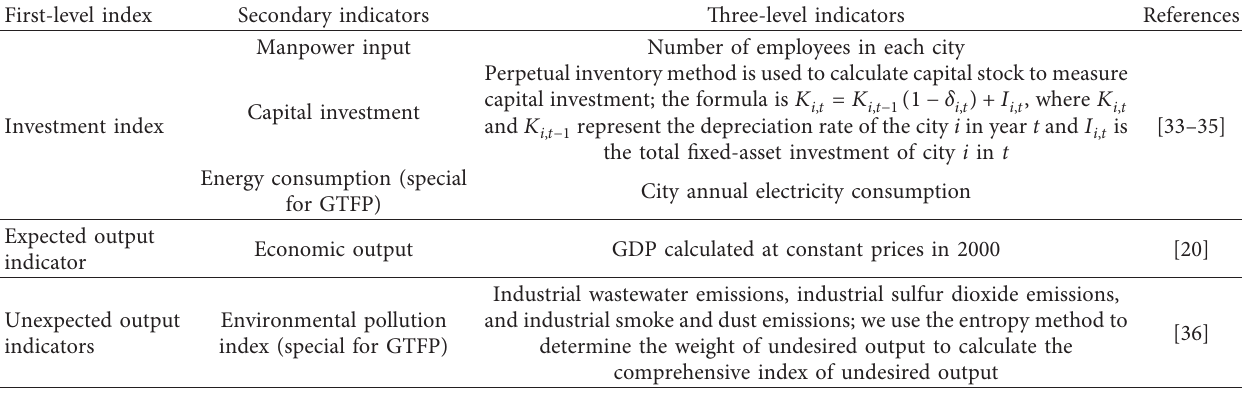
Table 1: Meaning and measurement of GTFP and TFP.